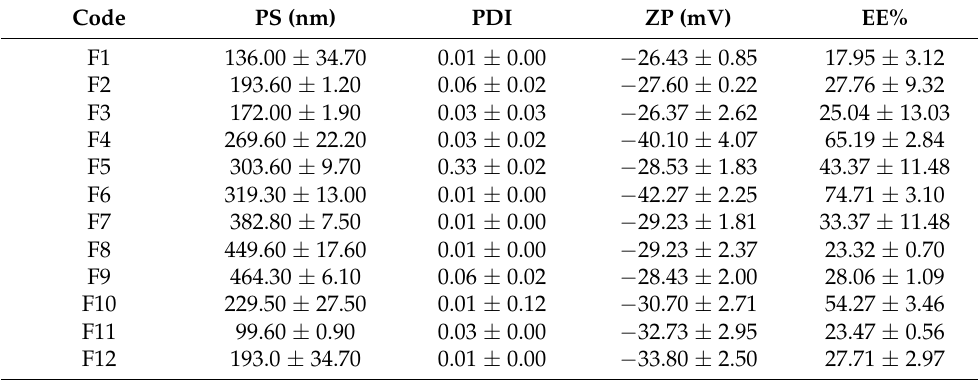
Table 3. The PS, PDI, ZP, and EE% of prepared niosomal formulation. Results are represented by mean ± SD ( n =